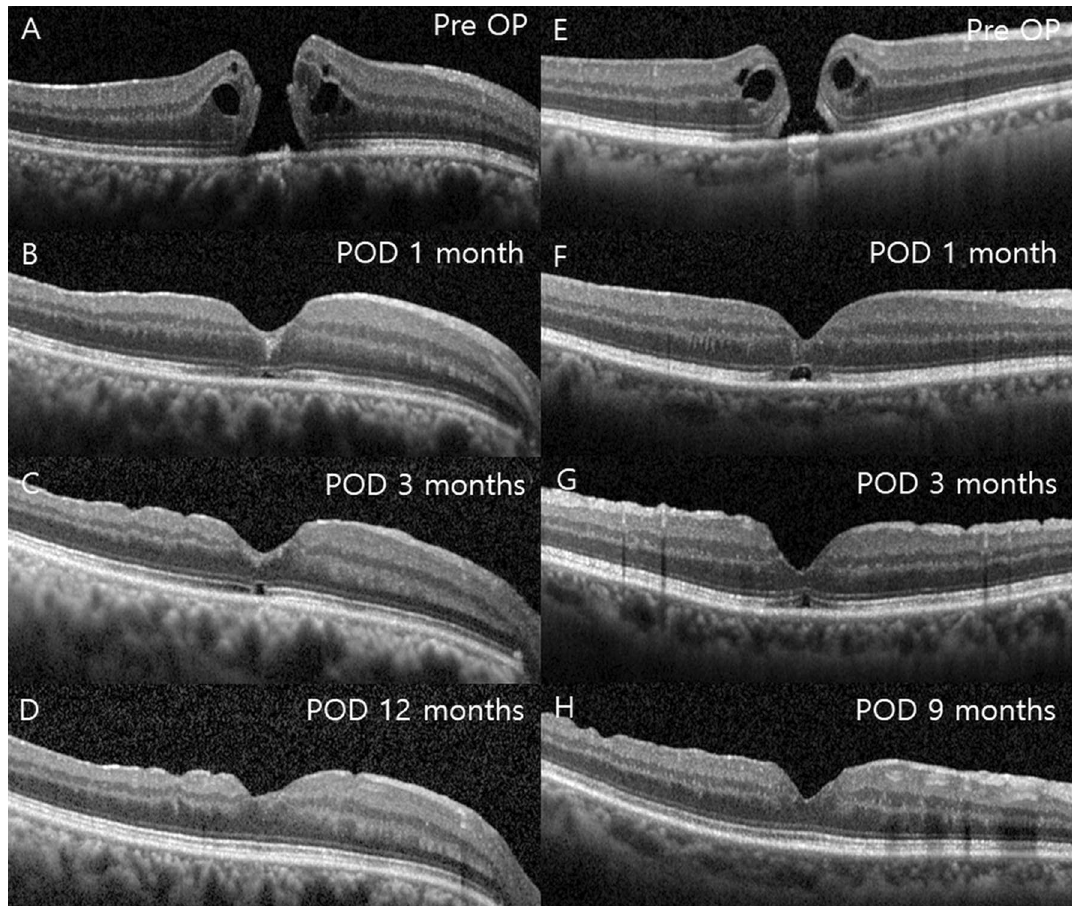
Figure 3. Two cases showing changes in the external limiting membrane (ELM), outer nuclear layer (ONL), and ellipsoid zone (EZ) during follow-up. The first case recovered its EZ at 12 months ( A – D ), and the second case recovered at 9 months after surgery ( E – H ). At 1 month, the ELM became intact, but the ONL and EZ were disrupted in the foveal area ( B , F ). At 3 months, the ONL recovered its continuity but the EZ was still disconnected ( C , G ). After the recovery of the ELM and ONL, the continuity and hyperreflectivity of the EZ were